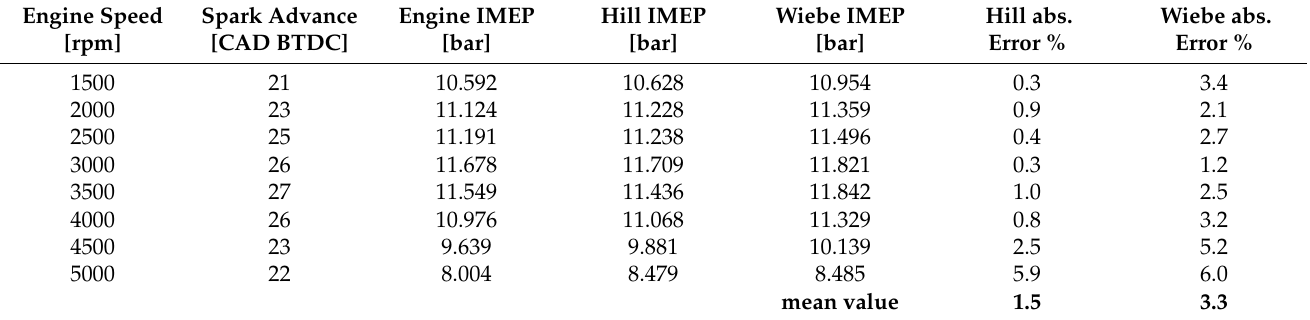
Table 9. Experimental and simulated IMEP with absolute prediction errors (60% NG; MAP = 1.2 bar).